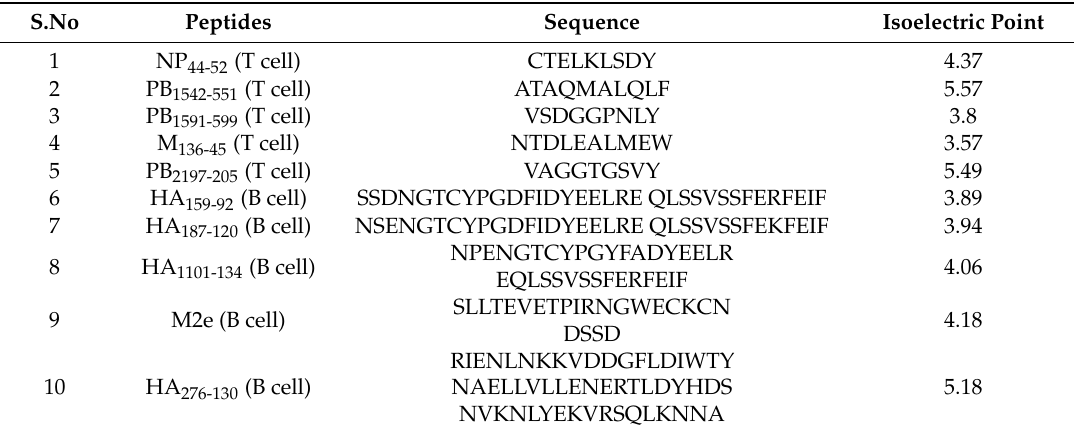
Table 1. Sequences and isoelectric points of influenza virus-specific conserved T cell and B cell